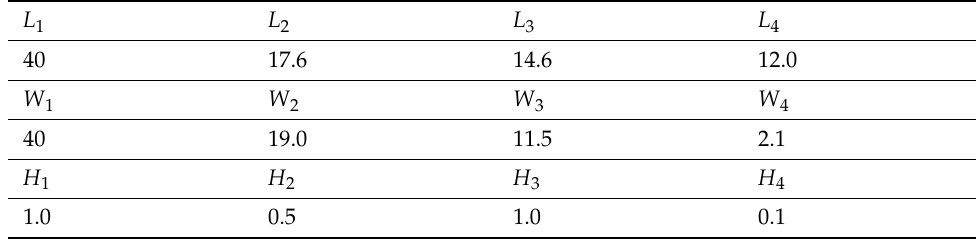
Table 1. Dimensions of the Optimized Antenna (Unit: